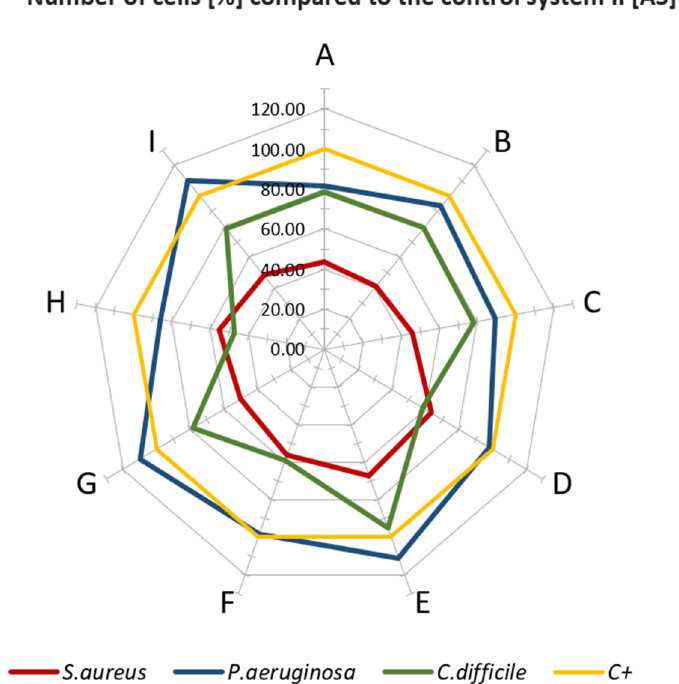
Figure 3. Plot of number of cells (%) compared to the control system II [AS]. Letters A–I: specific type of material applied.